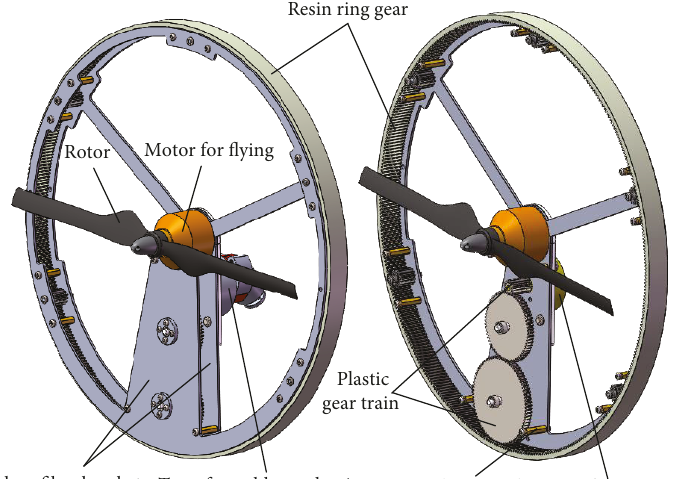
Figure 4: Structure of the driving wheel.